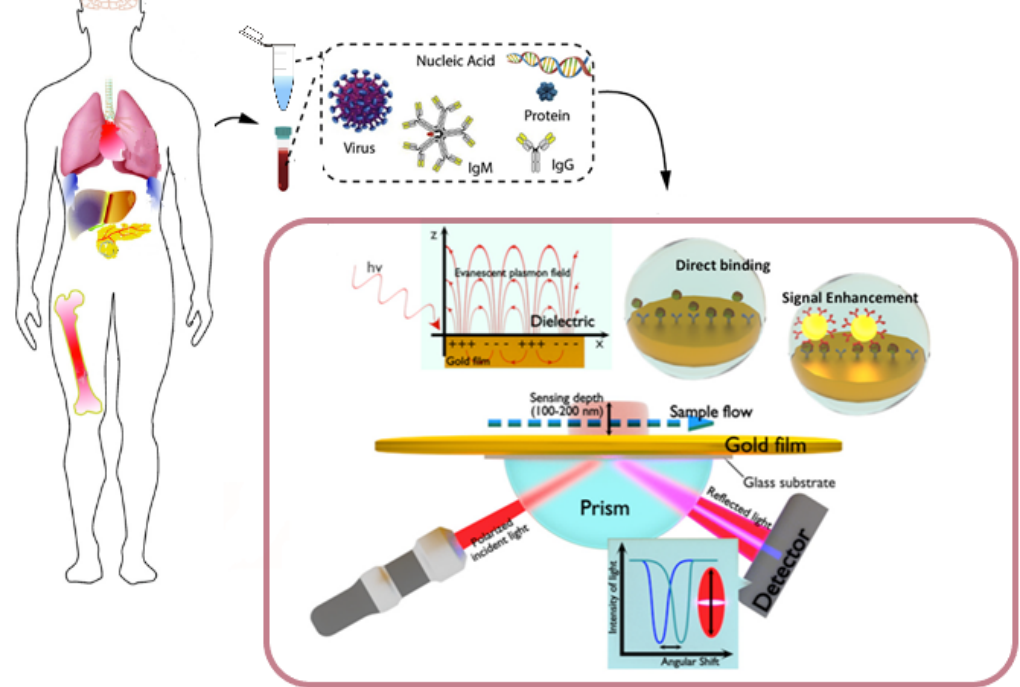
Figure 1. Clinical (plasma / serum / saliva / urine) biomarkers, including virus particles, nucleic acids, proteins and antibodies, that can be monitored by surface plasmon resonance (SPR)-based biosensors. The scheme in the box below represents a plasmonic sensing system based on the Kretschmann configuration. The incident light passes through a glass prism before being reflected by the sensing surface and captured by a detector. The refractive index at the interface and the surface plasmon wave frequency will change upon the binding of analytes. The amount of bound molecules can be measured in real time at a fixed incident angle or by tracking angle–SPR-resolved responses. The inset in the background depicts the generation of a surface plasmon wave that will propagate along the conductor–dielectric interface upon interaction with an incident plane-polarized light. Adapted with permission from Fehran et al. [10] (Copyright © (2018) Elsevier), Rapisuwon et al. [5] (under the terms and conditions of the Creative Commons CC BY License) and Chen et al. [15] (Copyright © (2019) Elsevier).